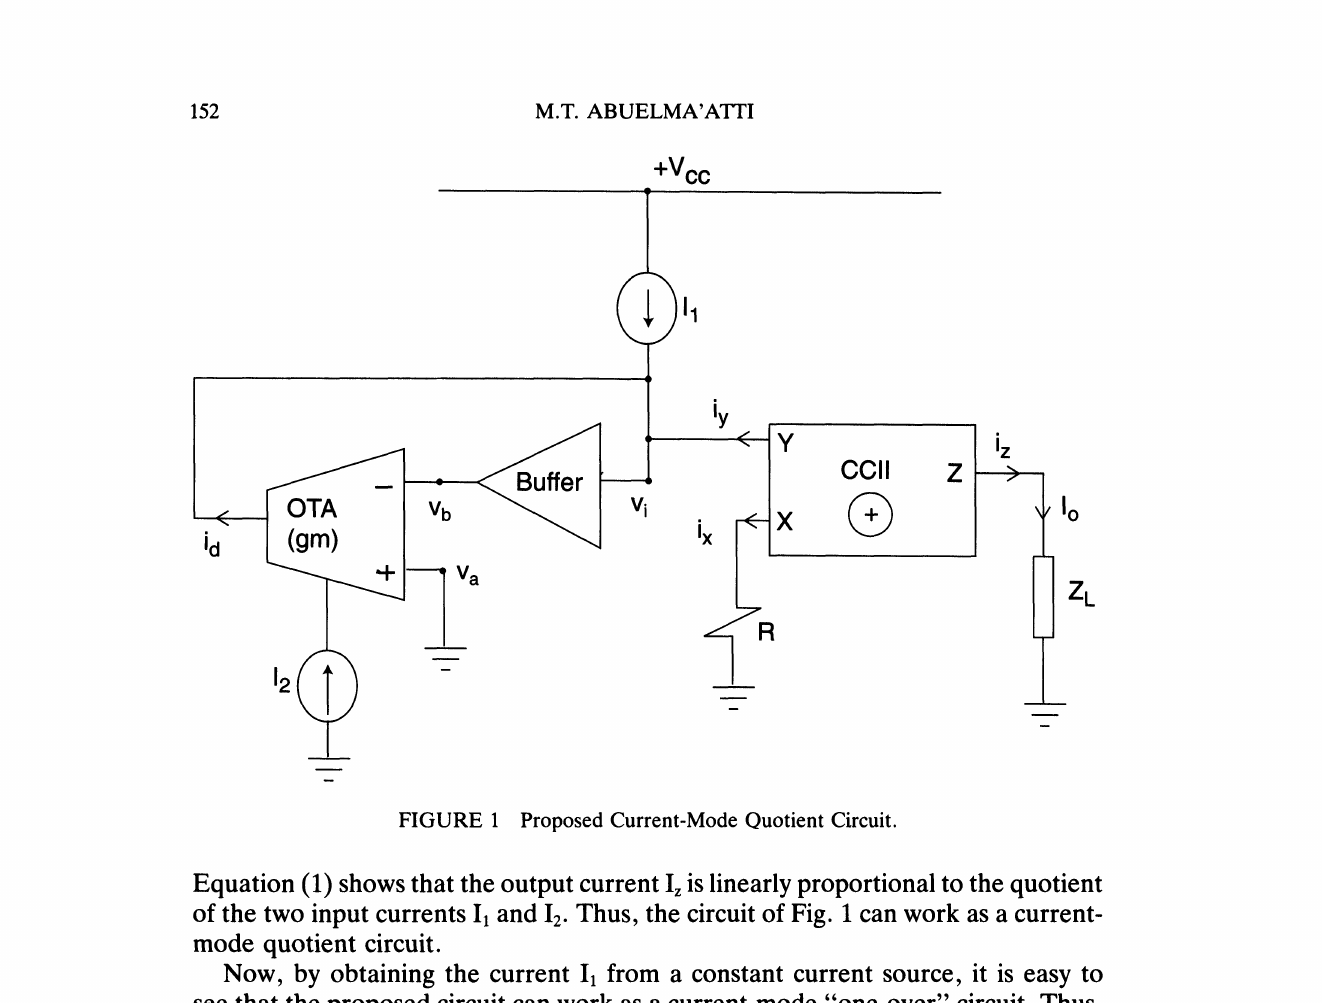
FIGURE Proposed Current-Mode Quotient Circuit.